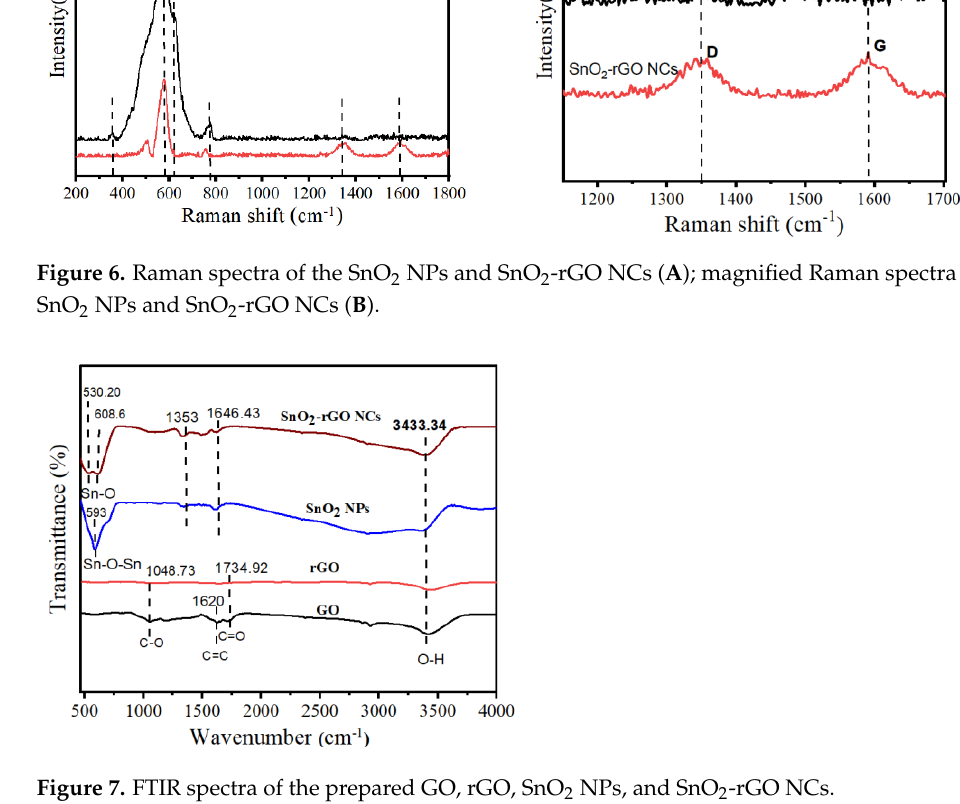
Figure 7. FTIR spectra of the prepared GO, rGO, SnO 2 NPs, and SnO 2 -rGO